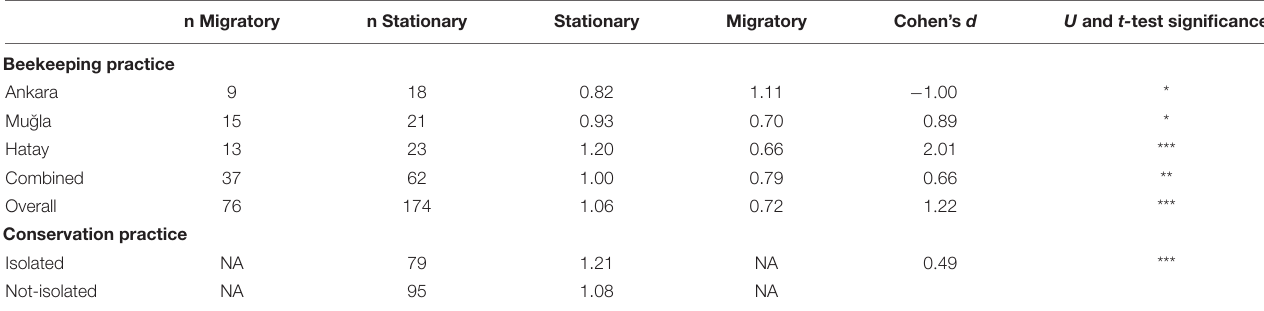
TABLE 1 | Genetic impact of beekeeping and conservation practices on (arcsine square-root transformed) membership coefficients to native clusters (* p < 0.05, ** p < 0.01, and *** p < 0.001). n Migratory n Stationary Stationary Migratory Cohen’s